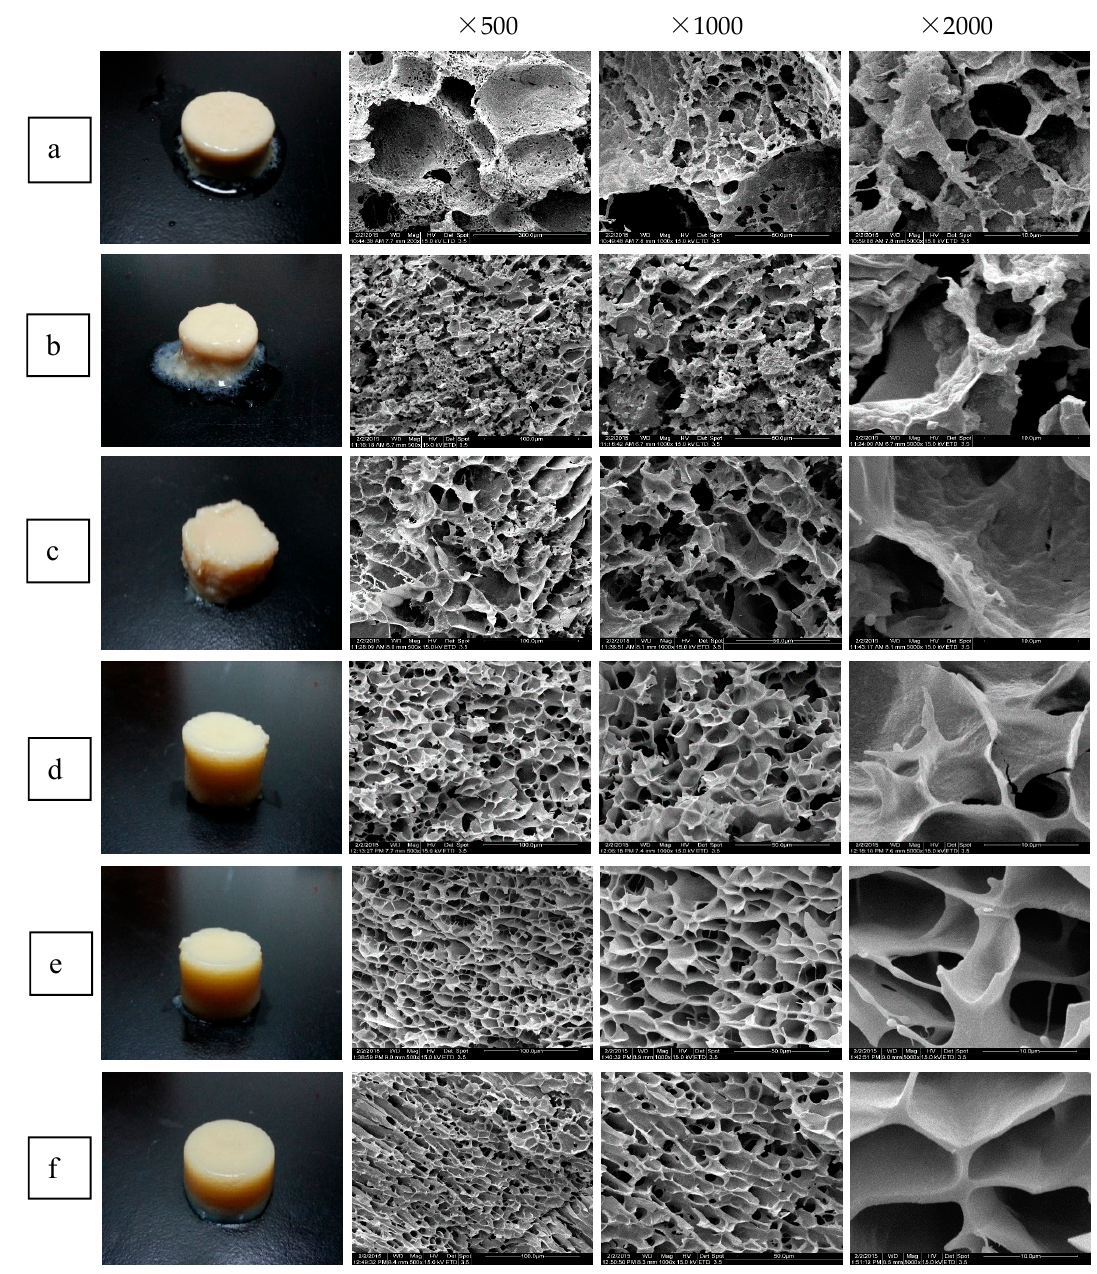
Figure 4. Appearance images and SEM observation of CFG-SPI DN hydrogels at different pH values. (( a ) pH = 5; ( b ) pH = 5.5; ( c ) pH = 6; ( d ) pH = 6.5; ( e ) pH = 7; ( f ) pH =